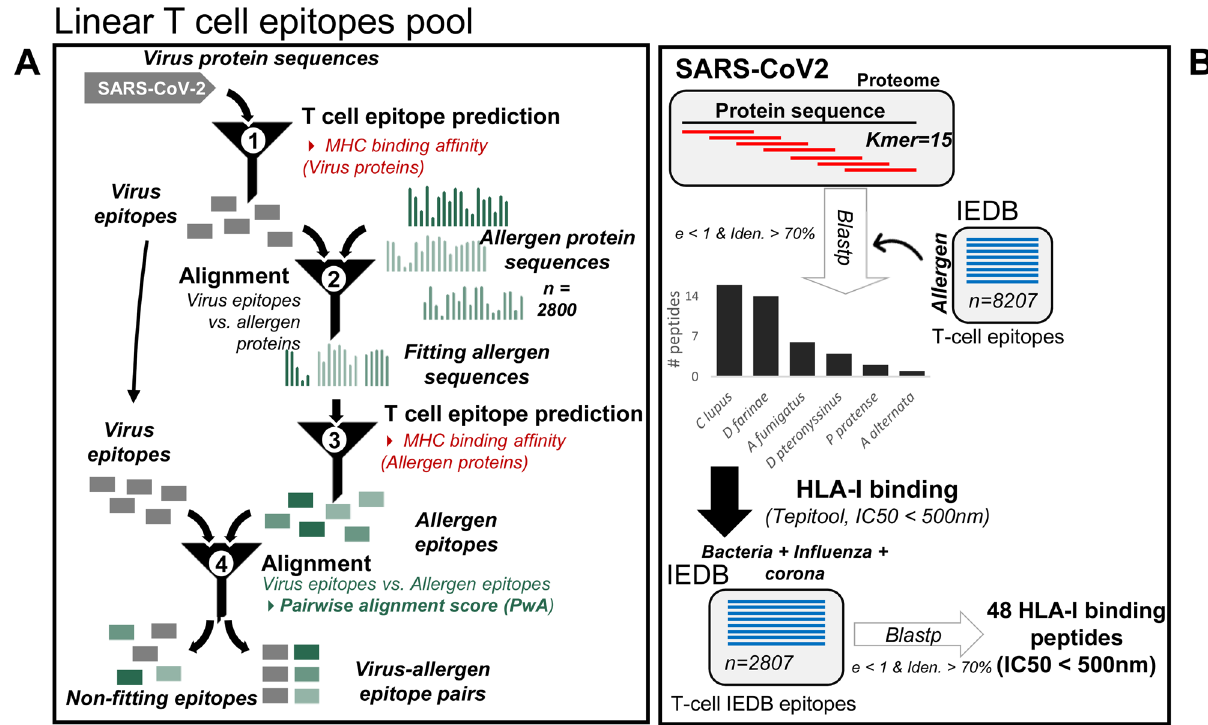
Figure 1. Schematic overview of the bioinformatics approaches. A Pipeline 1; SARS-CoV-2 proteins were aligned against > 2500 allergen protein sequences (see methods) and MHC class I-and II- restricted potentially cross-reactive T cell epitope pairs were identified for the most frequent human HLA alleles. B Pipeline 2; In an independent framework, we performed the comparative analysis of sequential kmers from SARS-CoV-2 protein sequences with known IEDB allergen peptides to predict the cross-reactive viral peptide pool.